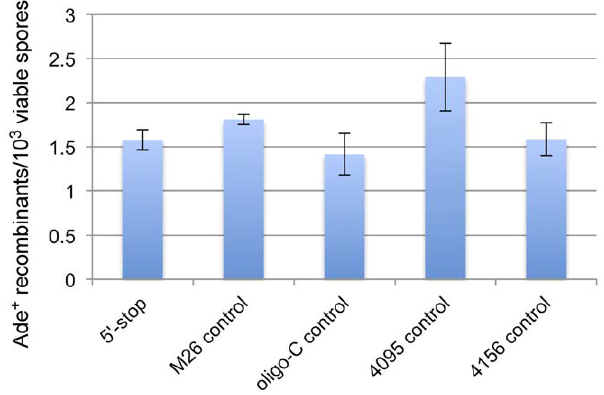
Figure 4. Two control alleles show significantly higher recombination than ade2-1007 (5 9 -stop). Control alleles containing promoter mutations were tested side-by-side with the ade2-1007 (5 9 - stop) allele to determine whether the elevated recombination observed in some of these controls (Fig. 2) is real or due to day-to-day variation. Bars indicate the mean frequency of recombinants from four or five crosses. Error bars indicate one standard deviation. Strains crossed to Wsc72 are from left to right: Wsc66 (5 9 -Stop; ade2-1007 ), Wsc116 ( M26 control; ade2-1026 ), Wsc135 ( Oligo-C control; ade2-1035 ), Wsc156 ( 4095 control; ade2-1038 ), Wsc134 ( 4156 control; ade2-1034 ).